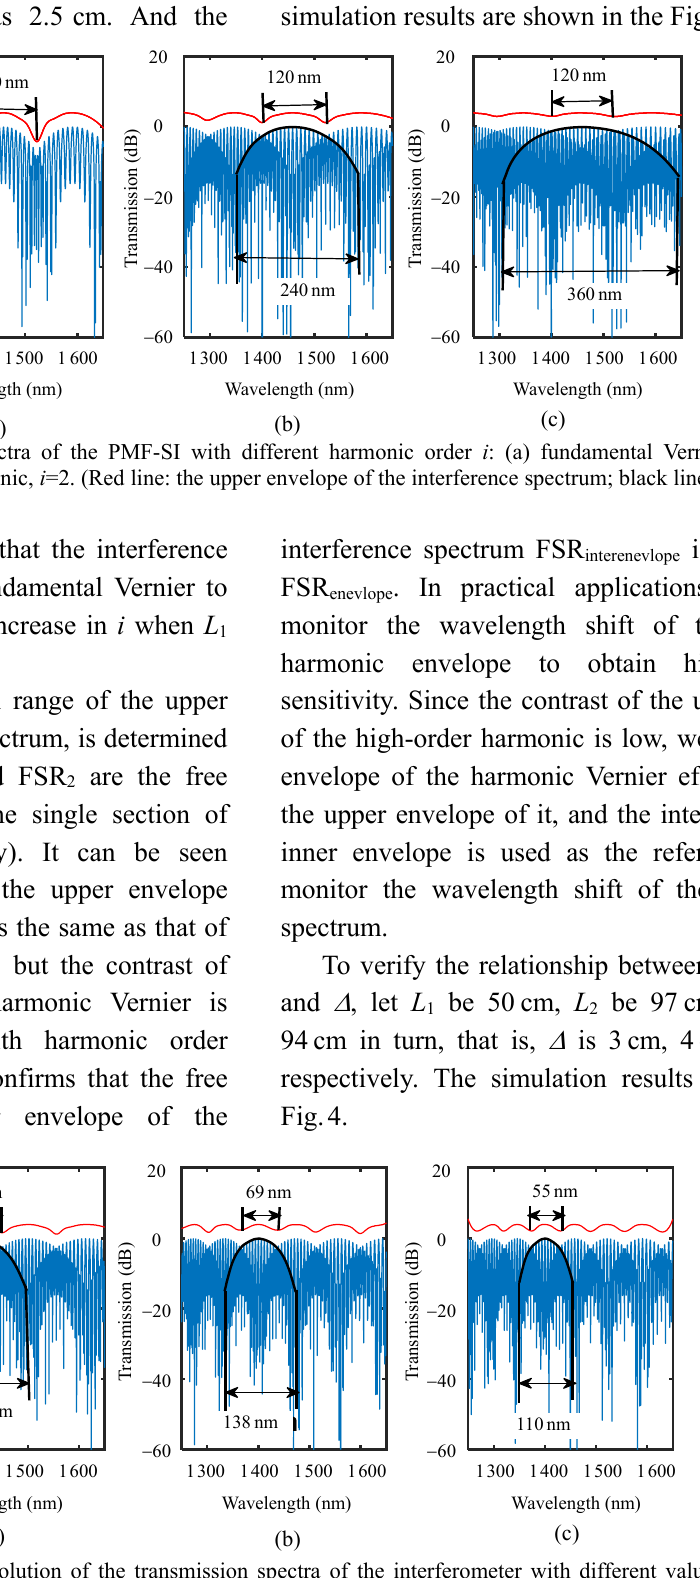
Fig. 4 Simulation results of the evolution of the transmission spectra of the interferometer with different values of Δ : (a) Δ =3, (b) Δ =4, and (c) Δ =5. (Red line: the upper envelope of the interference spectrum; black line: part of the inner envelope of the interference